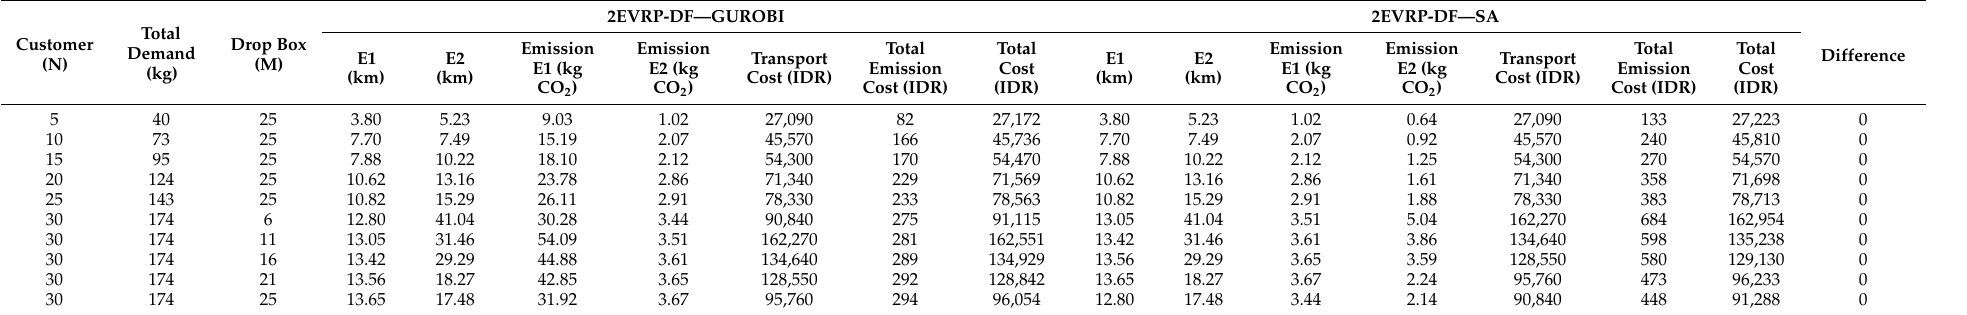
Table 3. Comparison of results between GUROBI & SA on small size instance.